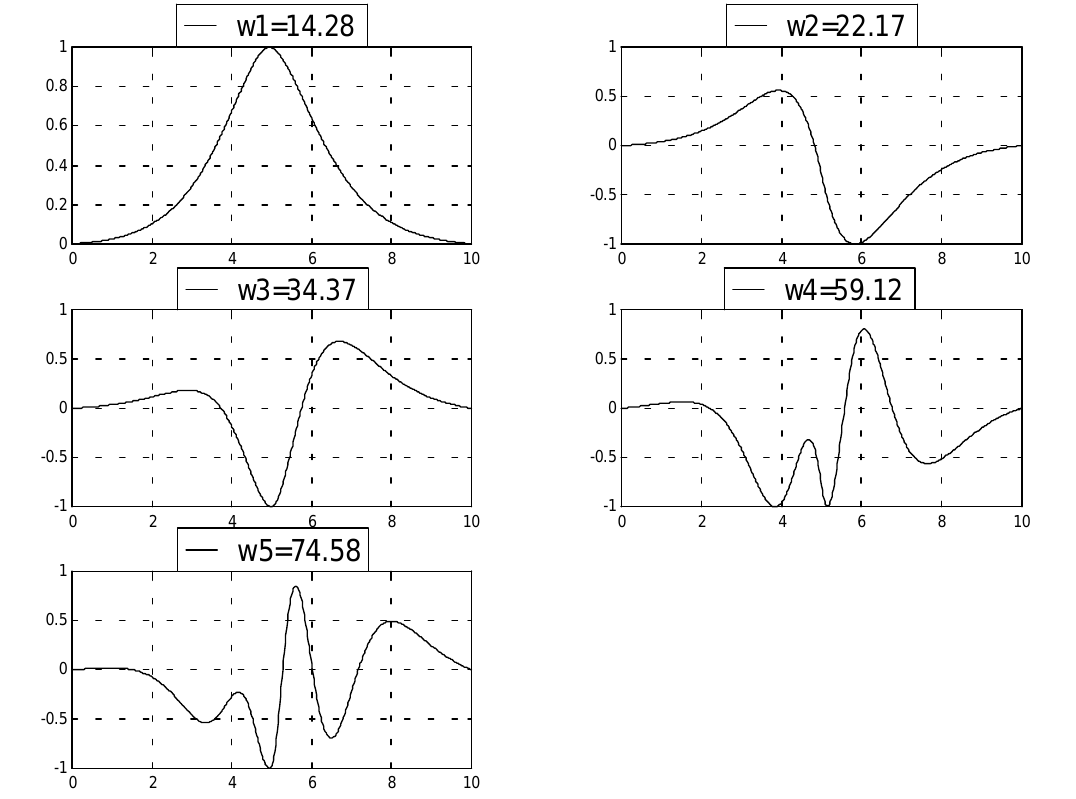
Fig. 11. First five eigenfunctions of an aluminum fixed-fixed rod with an exponentially decreasing-increasing modulus of